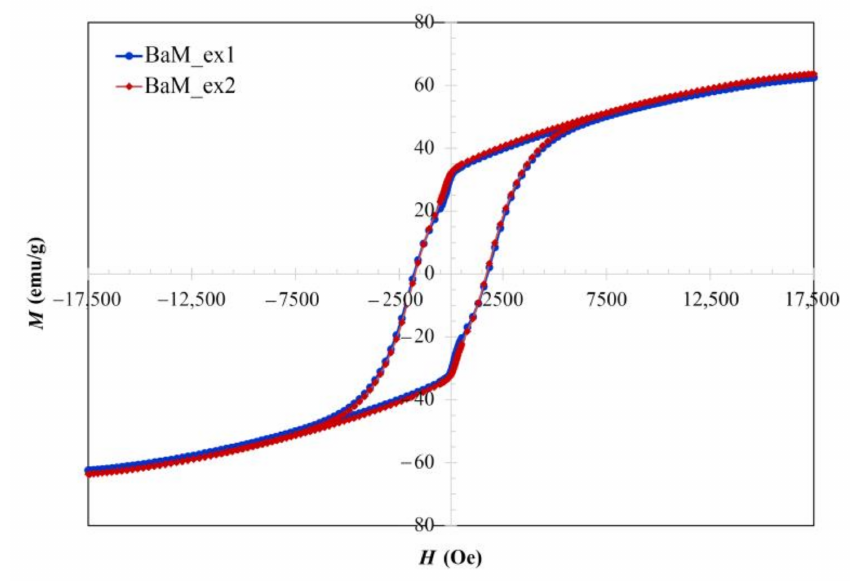
Figure 4. M-H curves of BaFe 12 O 19